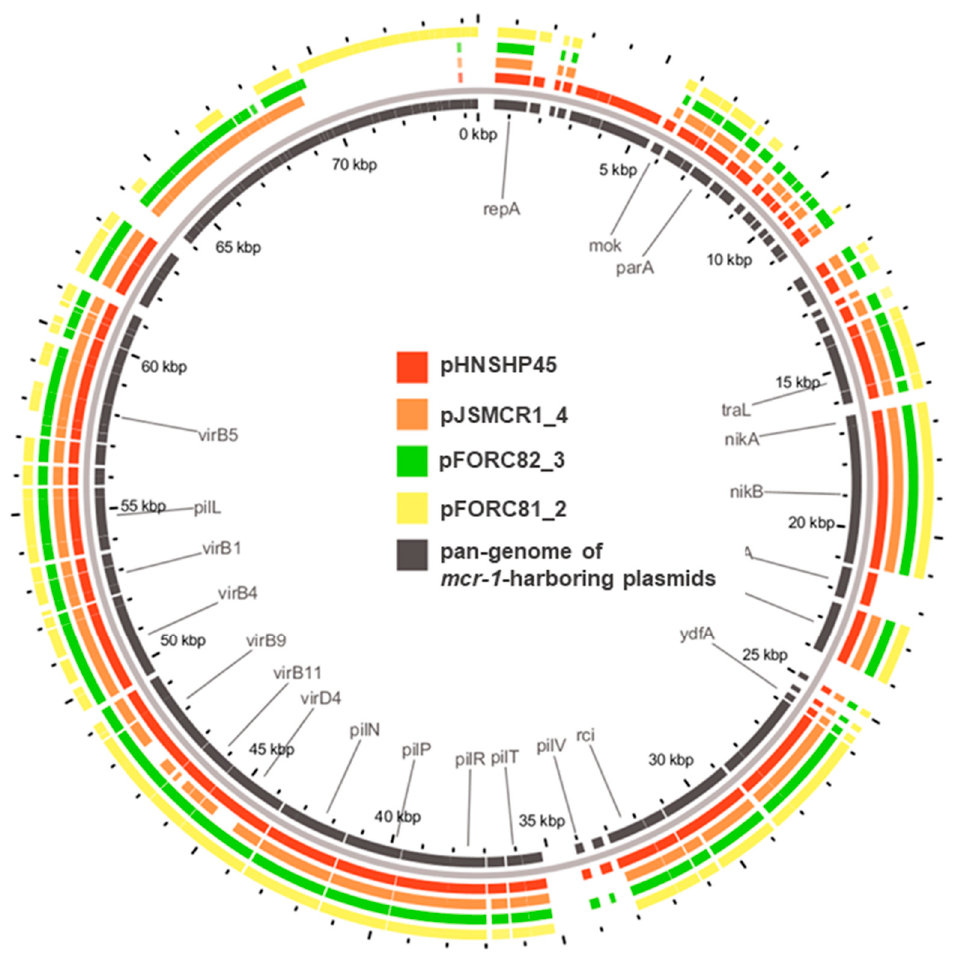
Figure 1. Sequence comparison of mcr-1 -harboring plasmids. pHNSHP45 was used as a reference. Black inner ring indicated the pan-genome of the mcr-1 -harboring plasmid.